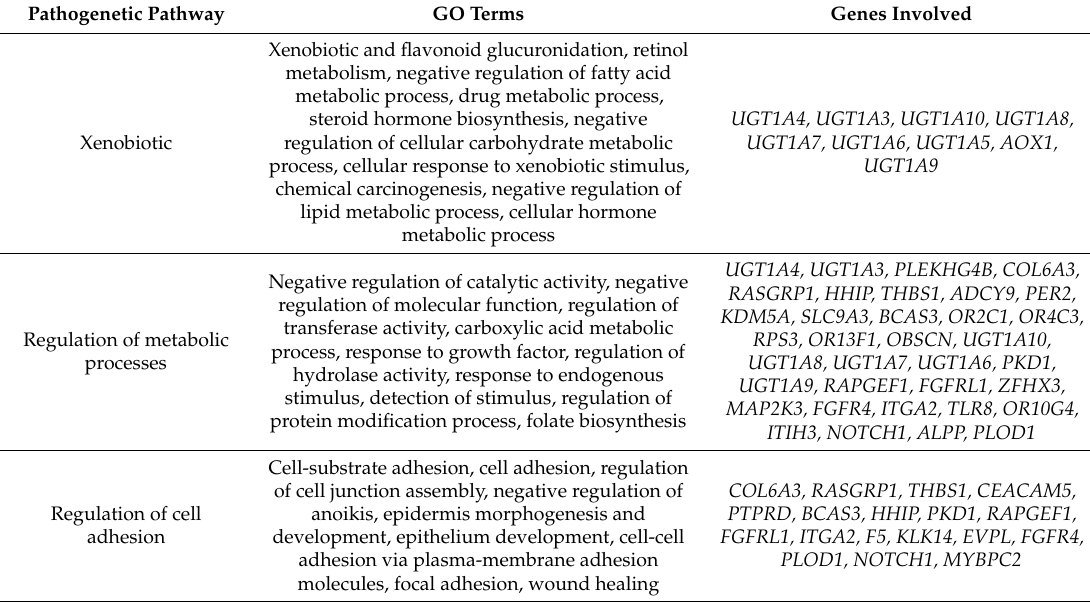
Table 2. Pathogenetic pathways from GO functional categories among selected genes co-segregating with gastroschisis *.